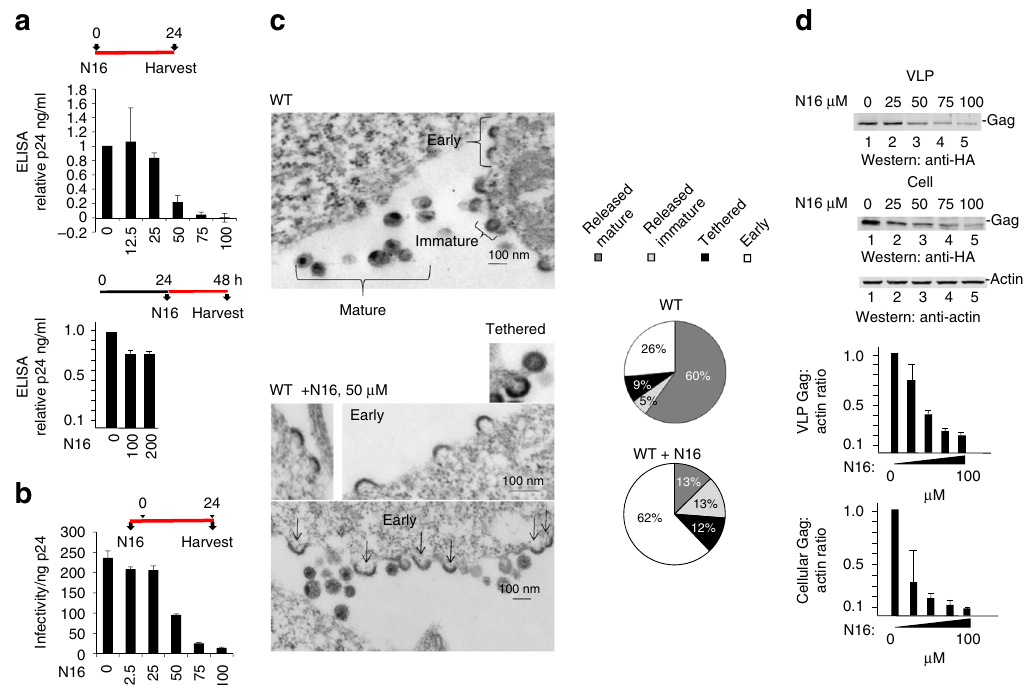
Fig. 1 N16 inhibits HIV-1 NL4-3 and Gag VLP production. a Effect on virus production. Virus particles from N16-treated 293T cells transfected with pNL4-3 as determined by ELISA assay. Top: The compound ( μ M concentration) was added 6 h prior to DNA transfection (pNL4-3 Δ Env + HIV-1 IIIB-Env) and tissue culture media was collected 24 h later. Bottom: the compound was added at the indicated concentration ( μ M) 24 h after DNA transfection and tissue culture media was collected 24 h later. Assay values were normalized to that of the DMSO carrier control. b Effect on virus infectivity. Infectious viral particles per ng p24 as determined by MAGI assay. c Left: Electron microscopy of particles at cell surface at 24 h post-N16 addition; right: quantitative analysis of budding morphologies. Cells expressing WT NL4-3 were exposed to DMSO carrier or 50 µ M N16. Change in ‘ Early ’ bud detection: χ 2 p -value < 0.0001. d Effects on Gag VLP production. Top: western blot analysis. Cells treated at the indicated concentration were transfected with DNA encoding Gag-HA. At the end of the treatment period, tissue culture media was removed for VLP isolation. Cells were suspended in lysis buffer. Blots were probed for Gag-HA and actin. Bottom: Quantitative analysis of ratio of VLP- or cell-associated Gag to actin normalized to the mock-treated control (0 µ M N16). Number of independent trials ( n ) for a , b , c , and d = 3, 2, 2 and 3, respectively; error bars represent 1 SD for the assay values (normalized to 0 µ M N16) for a and d ; for b , error bars represent 1 SD for the number of infected cells per ng